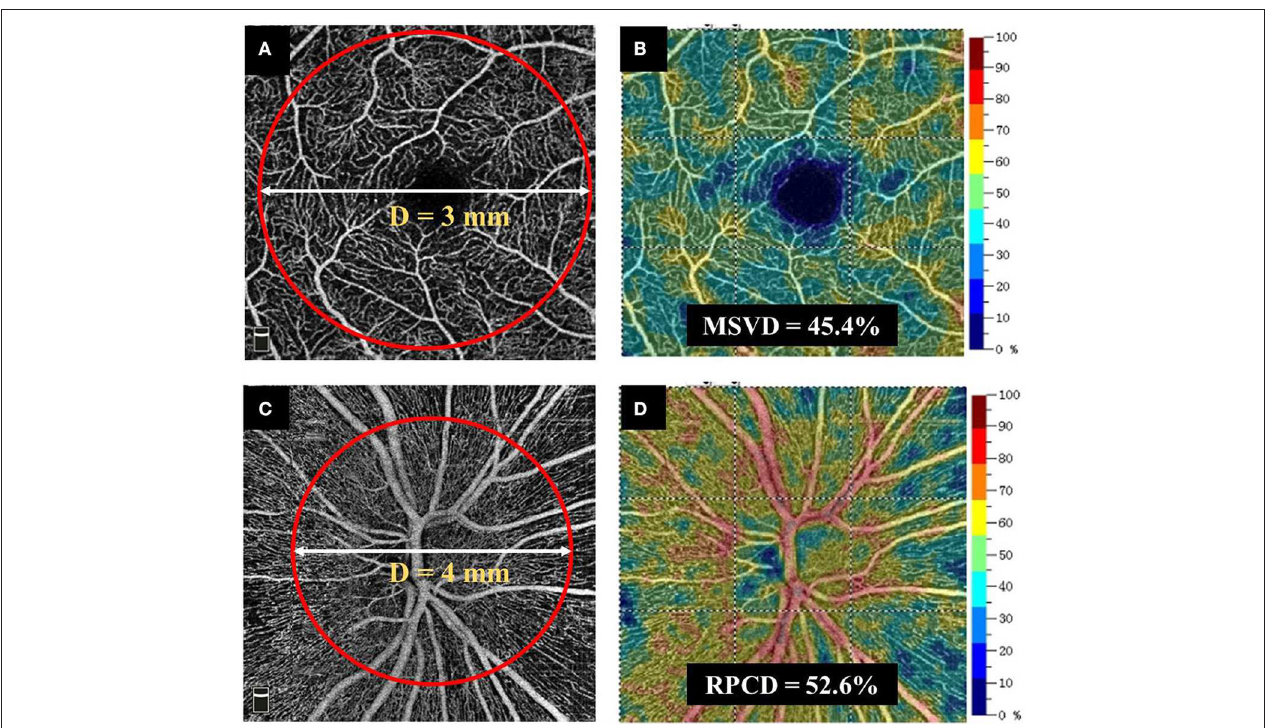
FIGURE 2 | Method for obtaining retinal vascular density. (A,B) MSVD was measured using the RTVue-XR Avanti spectral-domain OCT. MSVD was acquired through scans within the annular zone of 3mm diameter around the center of the macula, and the superficial capillary layer from 3 µ m below the ILM to the outer boundary of the inner plexiform layer was analyzed. (C,D) An en face angiogram of the radial peripapillary capillary segment was obtained by the maximum flow (decorrelation value) projection that extended from the ILM to the posterior boundary of RNFL. It covered a 4.5 × 4.5mm field of view centered on optic disc. The RPCD data were automatically measured by the built-in software in a 4-mm-diameter circle centered on the optic disc. MSVD, macular superficial vessel density; RPCD, radial peripapillary capillary density; OCT, optic coherence tomography. ILM, internal limiting membrane; OCT-A, optic coherence tomography